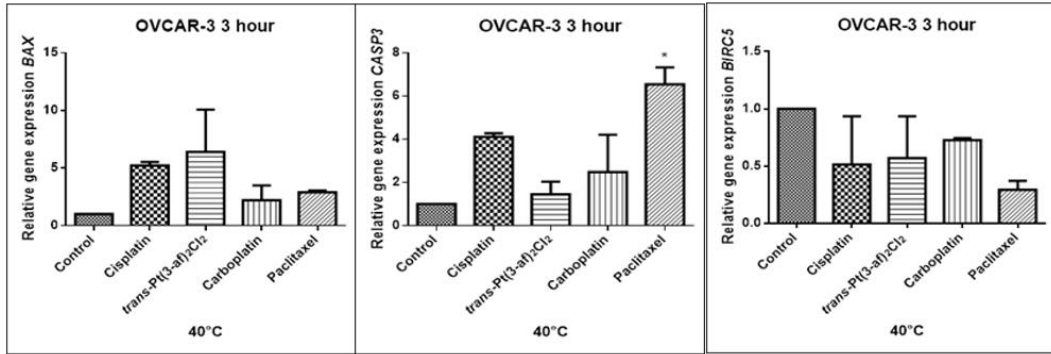
Figure 13. Level of gene expression of BAX, CASP-3, BIRC5 in ovarian cancer cells OVCAR-3. The gene expression level was presented as a relative value compared to a control equal to 1. The mean values marked by * ( p < 0.05) differ statistically significantly from the controls.